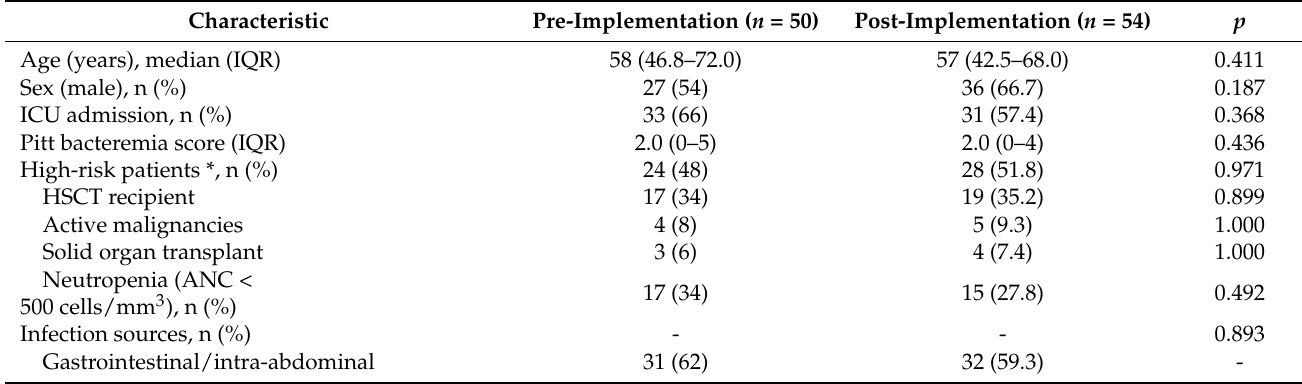
Table 1. Baseline